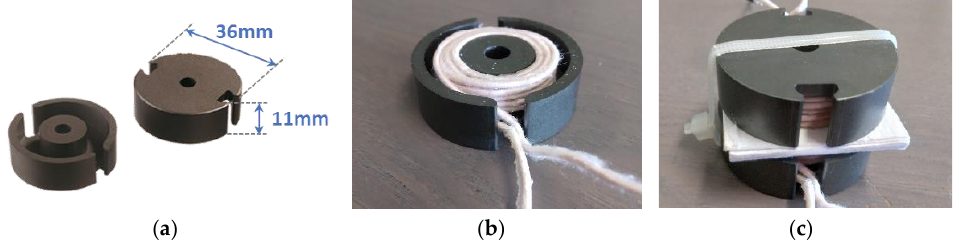
Figure 22. Custom IPT coils realized with Ferroxcube P36/22 – 3C91 pot cores and litz-wire 170/40: ( a ) P36/22 – 3C91 cores; ( b ) single custom coil; and ( c ) TX and RX coil set with 3 mm air-gap.